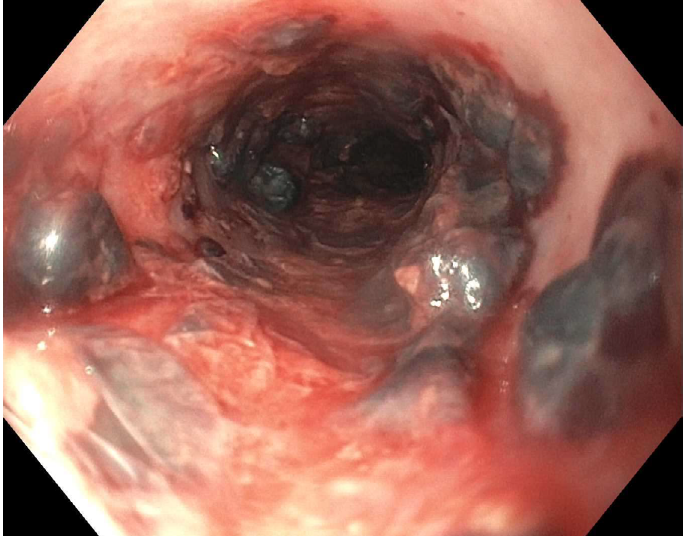
Figure 2. Necrotic mucosal protrusion in mid-third of the esophagus representing submucosal hematomas with orogastric tube extracted during the endoscopy